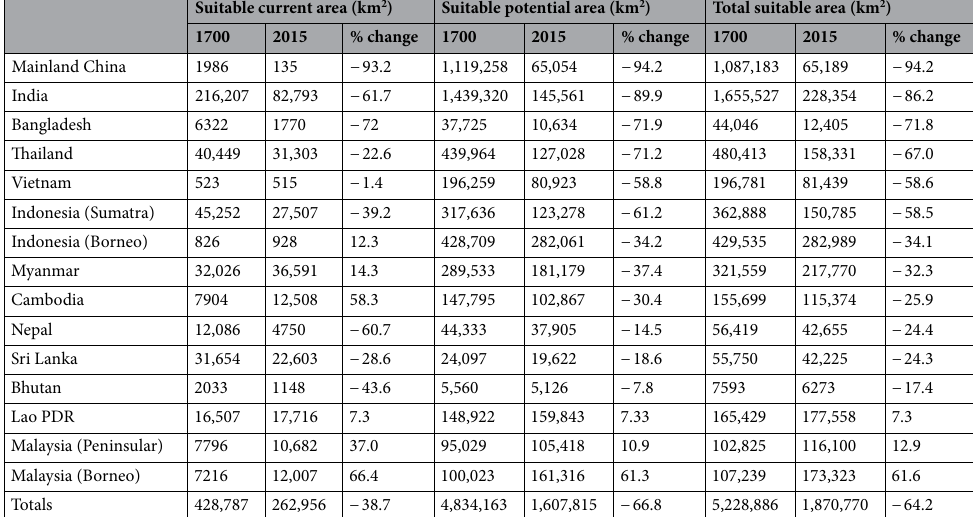
Table 2. Change in suitable habitat area by region from years 1700–2015. Areas are in km 2 , ordered from ranges that experienced the greatest loss to those with the greatest gain in total suitable area. “Suitable current area” refers to the current range, i.e. areas known to still contain elephants by the year 2000, whereas “Suitable potential area” refers to area that is outside the current range, where it is unknown whether elephants were ever present. The amount of suitable area within current range is 14% of the total suitable area.